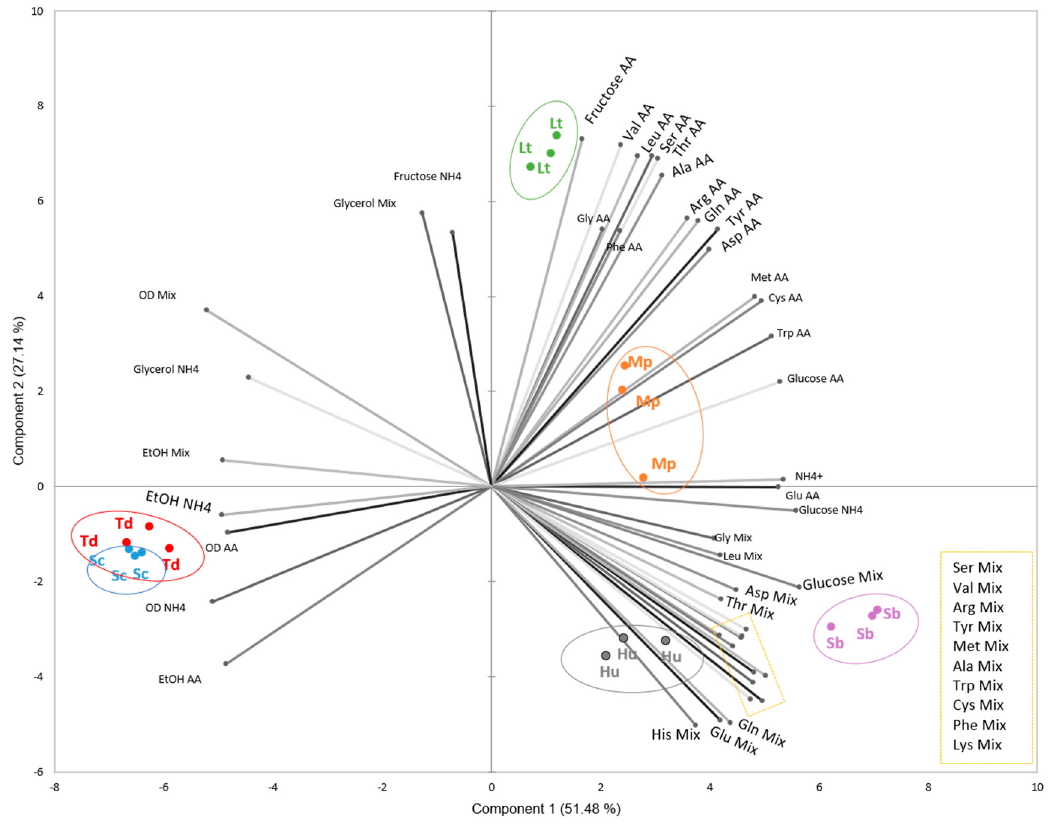
Figure 7. Biplot of principal component analysis (PCA) using nitrogen concentration, OD 600 , and the glucose, fructose, glycerol, and ethanol contents at 48 h in all media as variables. The explicative variables were distributed along the PCA axes as follows: Component 1 ( + ): glucose, aspartic acid (Asp), glutamic acid (Glu), serine (Ser), glutamine (Gln), histidine (His), glycine (Gly), threonine (Thr), arginine (Arg), alanine (Ala), tyrosine (Tyr), valine (Val), methionine (Met), cysteine (Cys), tryptophan (Trp), leucine (Leu), phenylalanine (Phe), lysine (Lys) (SM-Mix); glucose, Asp, Glu, Tyr, Met, Cys, Trp (SM-AA); glucose, ammonium (SM-NH 4 + ). ( − ): OD 600 , ethanol (SM-Mix); OD 600 , ethanol (SM-AA),